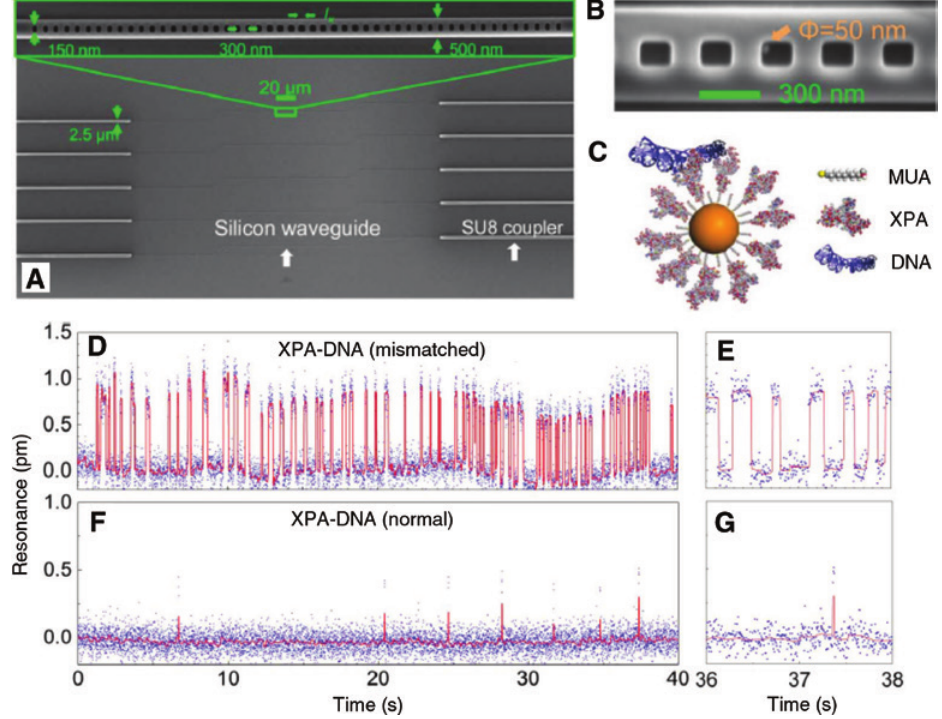
Figure 34: Real-time monitoring of single DNA-XPA dynamics with a hybrid system. There is an SEM picture of (A) multiplexed PhC nanobeam cavities together with the waveguiding components for input/output coupling and (B) the gold nanoparticle trapped within. An orange arrow points to the 50-nm diameter Au particle in the central grating. (C) Biofunctionali- sation of the Au nanoparticle, immobilising XPA proteins on a self-assembled monolayer of 11-mercaptoundecanoic acid (11-MUA) attached to the Au and which interacts with the dsDNA. (D)–(G) Resonance signal tracking in real time, revealing binding dynamics of (D) and (E) mismatched dsDNA and XPA in standard binding buffer (dsDNA concentration = 10 nm), as well as (F) and (G) normal dsDNA and XPA serving as a control. Adapted from